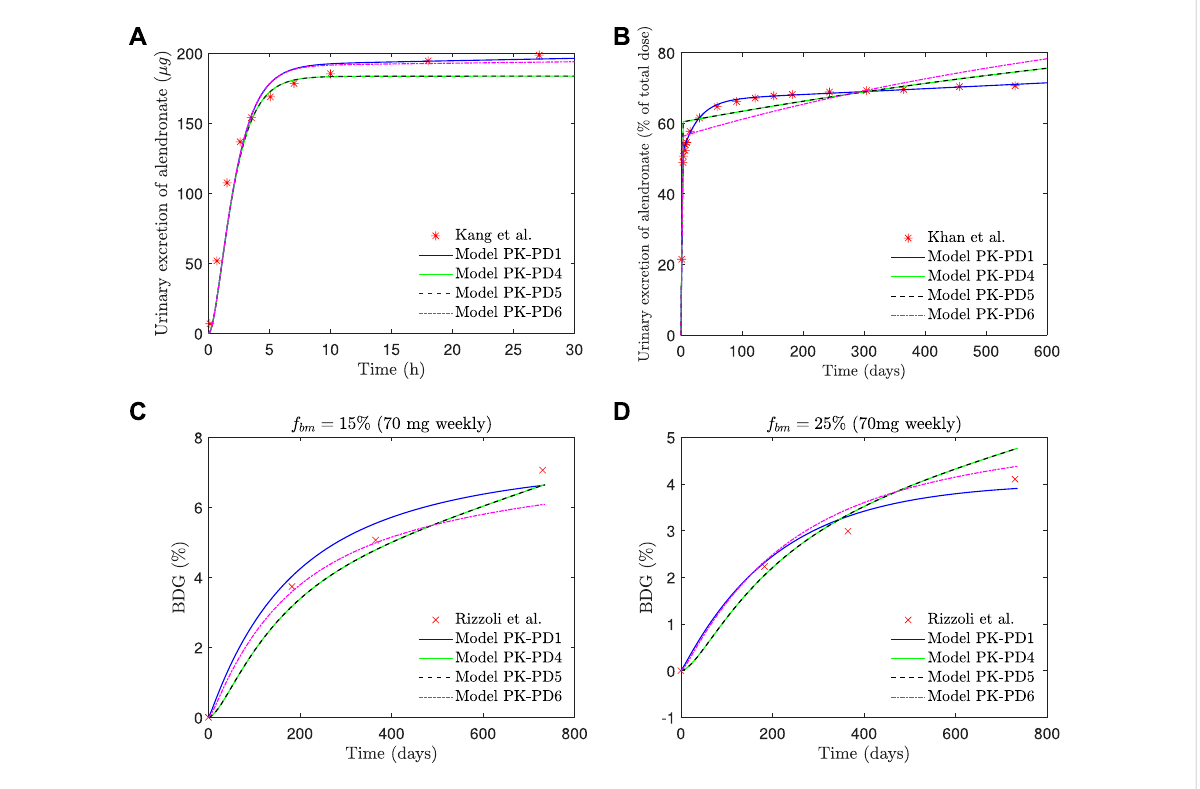
FIGURE 9 PK-PD1 , PK-PD4 , PK-PD5, and PK-PD6 model results. (A) Alendronate short-term urinary excretion vs. time; (B) alendronate long-term urinary excretion vs. time; (C) BDG vs. time for hip, that is, f bm = 15% and (D) BDG vs. time for lumbar vertebra, that is, f bm = 25% for a once-weekly 70 mg